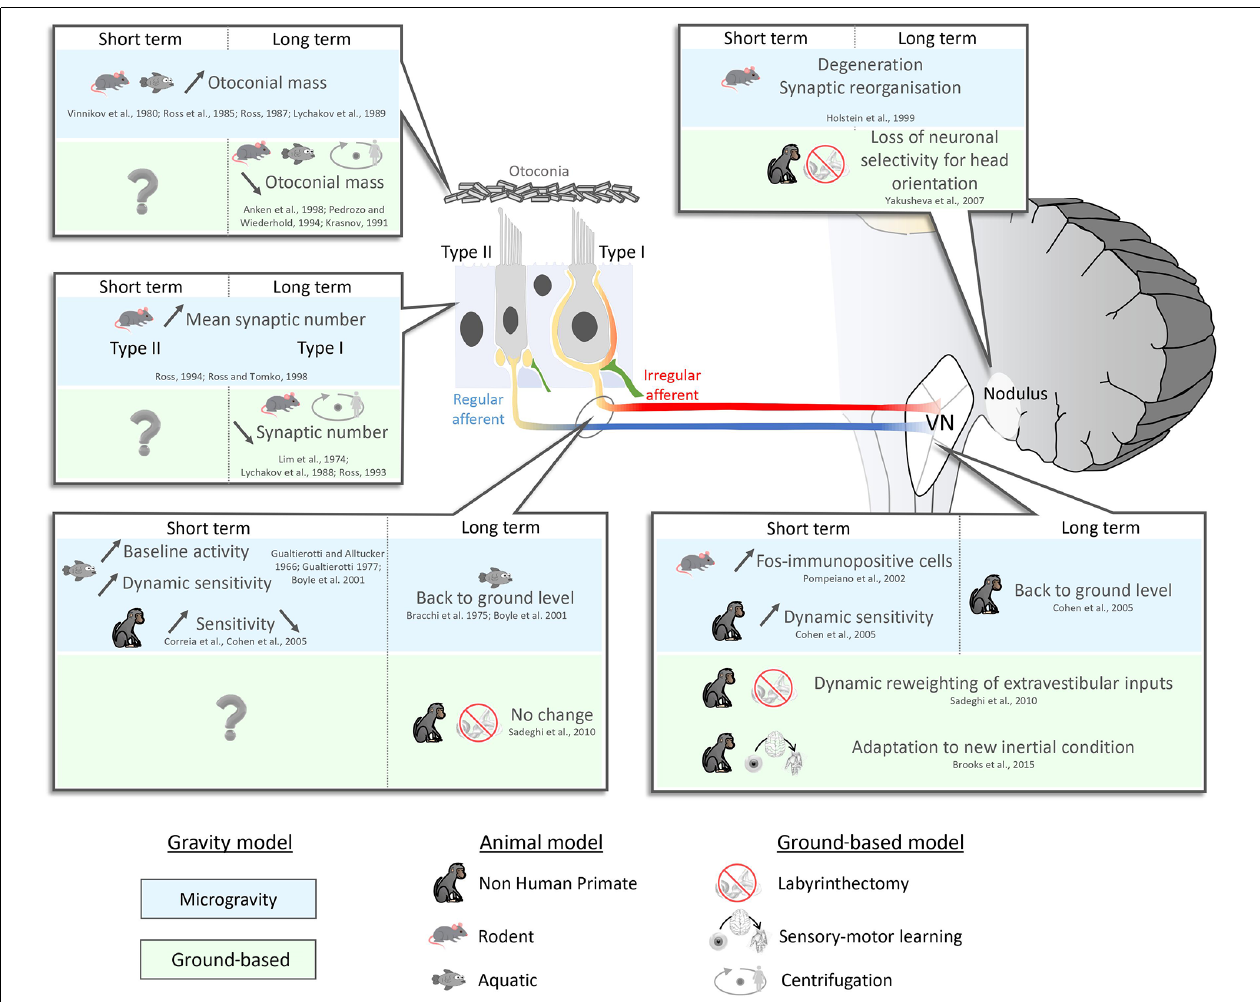
FIGURE 1 | Neurophysiological short- ( < 7 days) and long (>7 days) term- adaptation to microgravity and ground-based model. Upper left panel : the mass of the otoconia increases following short-term exposure to microgravity (Vinnikov Ia et al., 1980; Ross et al., 1985; Lychakov et al., 1989). This increase in mass is assumed to be maintained as long as there is no change in the gravitational environment. The opposite phenomenon occurs in hypergravity (decrease in mass; Krasnov, 1991; Pedrozo and Wiederhold, 1994; Anken et al., 1998; reviewed in Cohen et al., 2005). To date, however, the time course is unknown since testing was only done after long-term centrifugation (>24 days). Middle left panel : After 7–9 days in microgravity, type II vestibular hair cells increase in size and number (Ross, 1993, 1994, 2000). Then after 2 weeks in microgravity, the number of type I cells increases as well (Ross and Tomko, 1998). In hypergravity, only type II hair cells show a significant decrease in number (e.g., following 14–30 days of centrifugation; Lychakov et al., 1989; Ross, 1993). Bottom left panel : Immediately after entering microgravity, studies across species have reported increases in vestibular afferent baseline activity and sensitivity (Gualtierotti and Alltucker, 1967; Gualtierotti, 1977; Boyle et al., 2001). However, when considered alone, studies in NHPs have been inconclusive as some report increases and other report decreases in sensitivity (Correia et al., 1992; Cohen et al., 2005). After 5 days in microgravity, vestibular afferent responses return to ground levels (Bracchi et al., 1975; Boyle et al., 2001). On earth, 1 month after complete unilateral vestibular lesion, afferent responses in the intact nerve remain comparable to control levels (Sadeghi et al., 2007, 2010, 2011, 2012). Bottom right panel : Across animal models, the sensitivities of vestibular nuclei neurons initially increase in microgravity and then return to baseline levels after a week (Pompeiano et al., 2002; Cohen et al., 2005). On earth, following labyrinthectomy, vestibular nuclei neurons that normally only respond to vestibular input before lesion, show the emergence of responses to extravestibular inputs (efference copy, proprioception) after lesion (Sadeghi et al., 2007, 2010, 2011, 2012). During sensory-motor adaptation, vestibular neurons update their response to altered sensory feedback (Brooks and Cullen, 2014; Brooks et al., 2015; Mackrous et al., 2019). Top right panel : The cerebellum displays synaptic reorganization as early as 24 h following the transition to microgravity, which remains for at least 18 days (Holstein et al., 1999). On earth, following labyrinthectomy, cerebellar neurons lose their ability to discriminate between tilt and translation (Yakusheva et al., 2007).